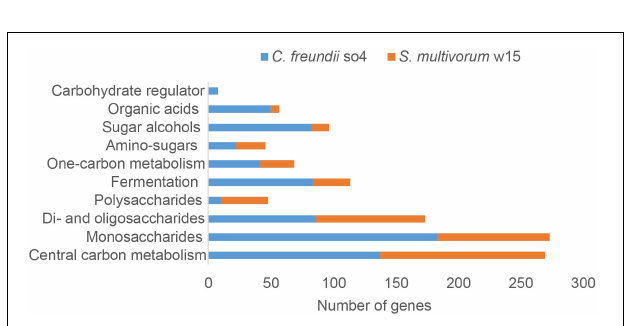
FIGURE 3 | Numbers of genes encoding proteins associated with carbohydrate metabolism found in the genomes of C. freundii so4 (blue) and S. multivorum w15